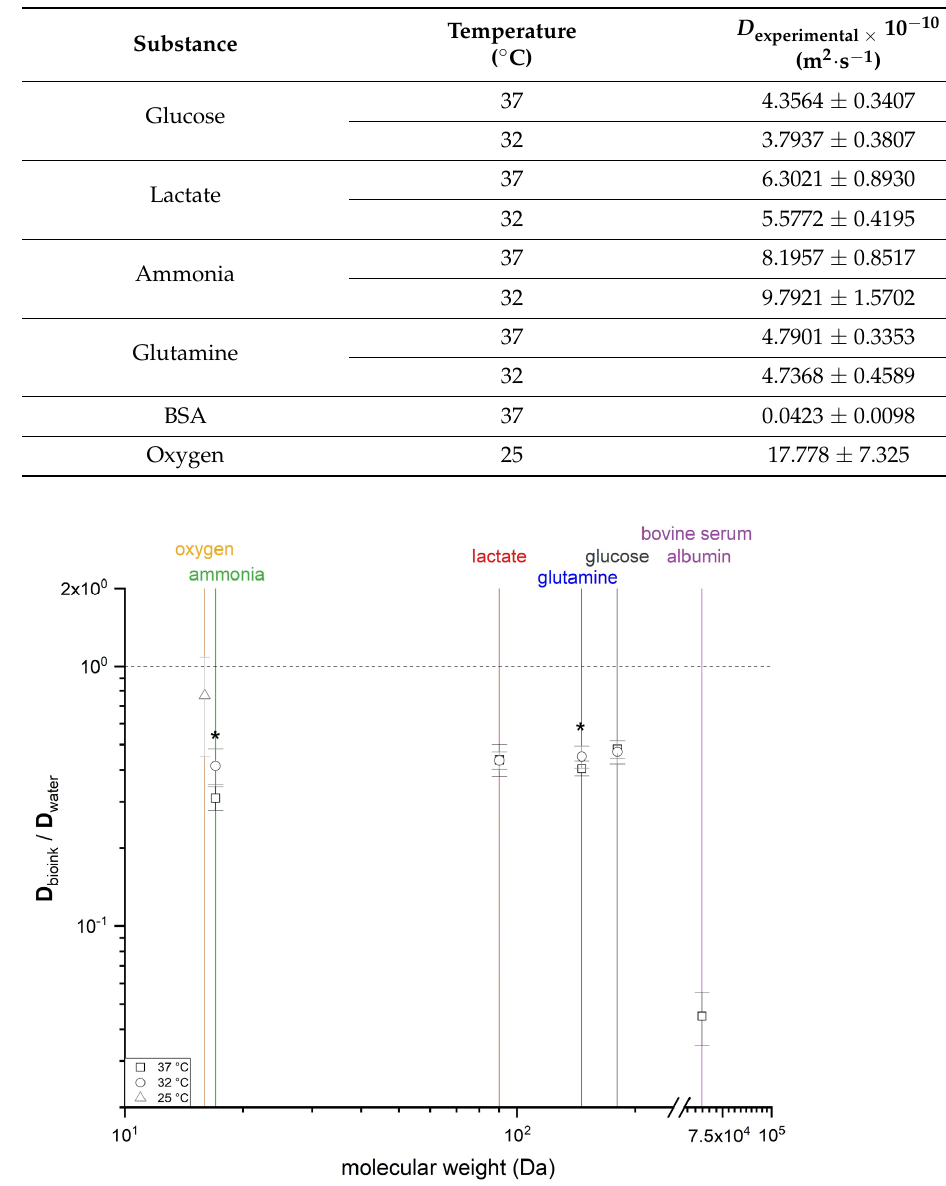
Figure 4. Effective diffusion coefficients of oxygen, ammonia, lactate, glutamine, glucose, and bovine serum albumin (BSA) through the bioink compared to water, as a function of the molecular weight and temperature. Data are mean values ± SD ( n = 10 for all molecules except oxygen, where n = 4). Statistical significance was tested for the samples, differing in temperature, by Kruskal–Wallis ANOVA (* p <